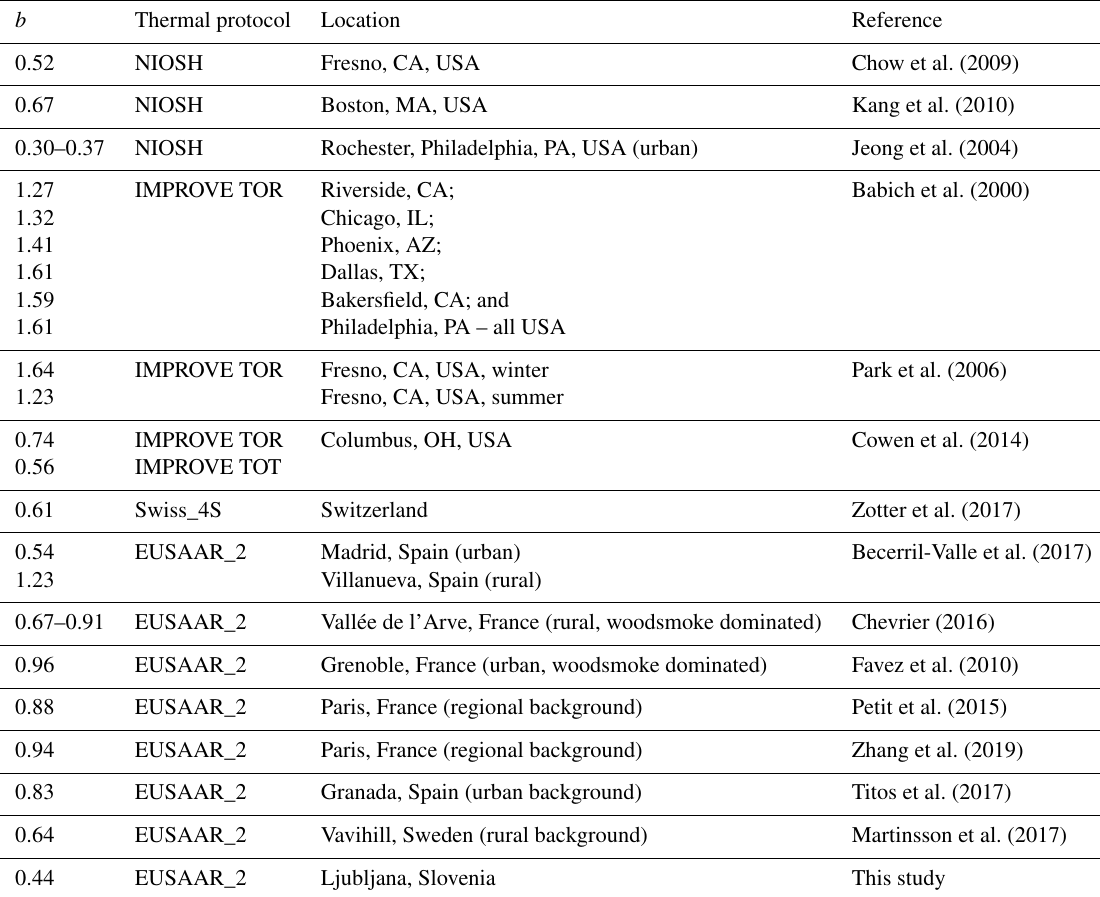
Table 3. Summary of b values (Eqs. 2, 8), where EC was determined by performing thermal optical analysis (NIOSH, IMPROVE TOT, IMPROVE TOR, SWISS_4S and EUSAAR_2) on 24h filters, while BC was measured by the Aethalometer.